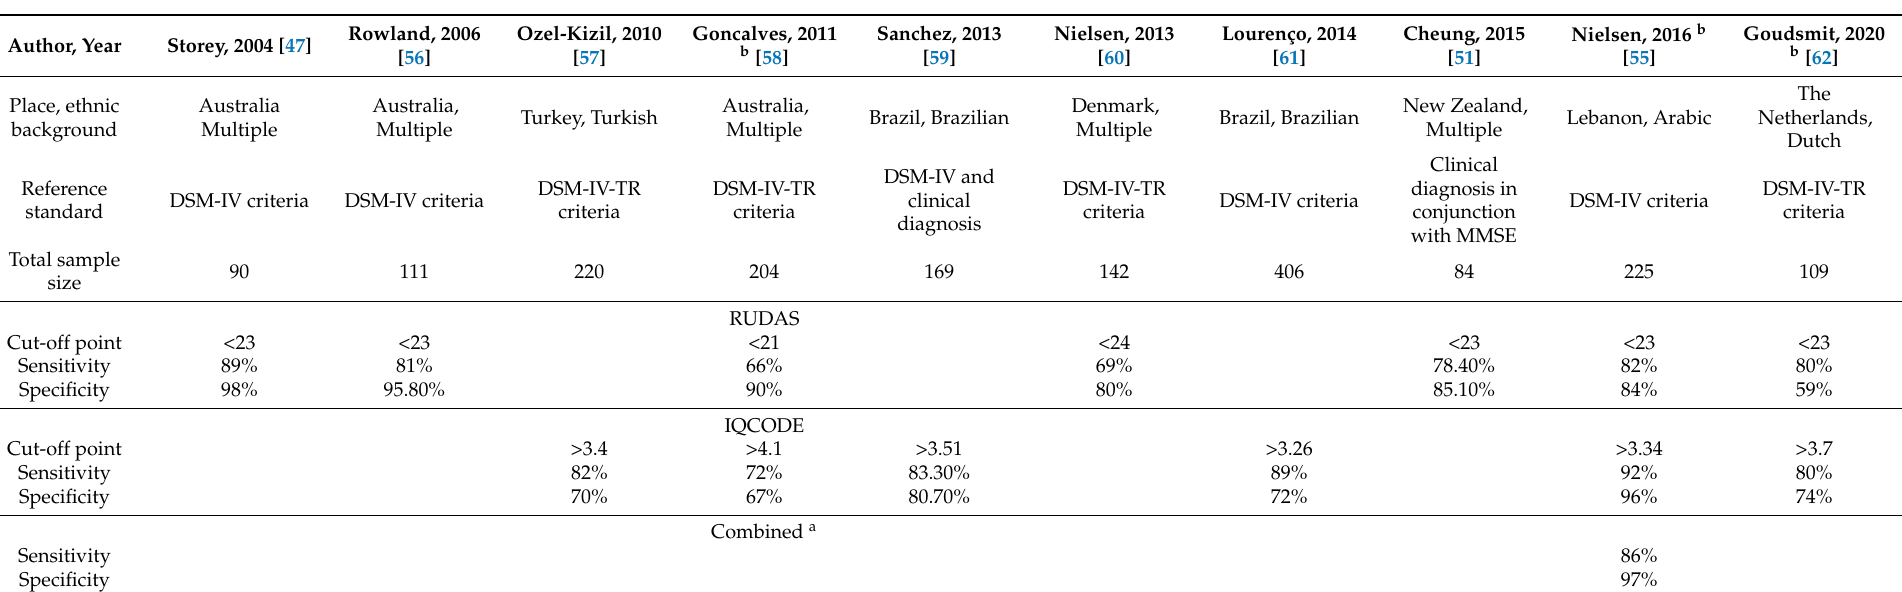
Table 2. RUDAS and IQCODE sensitivity and specificity in samples from different